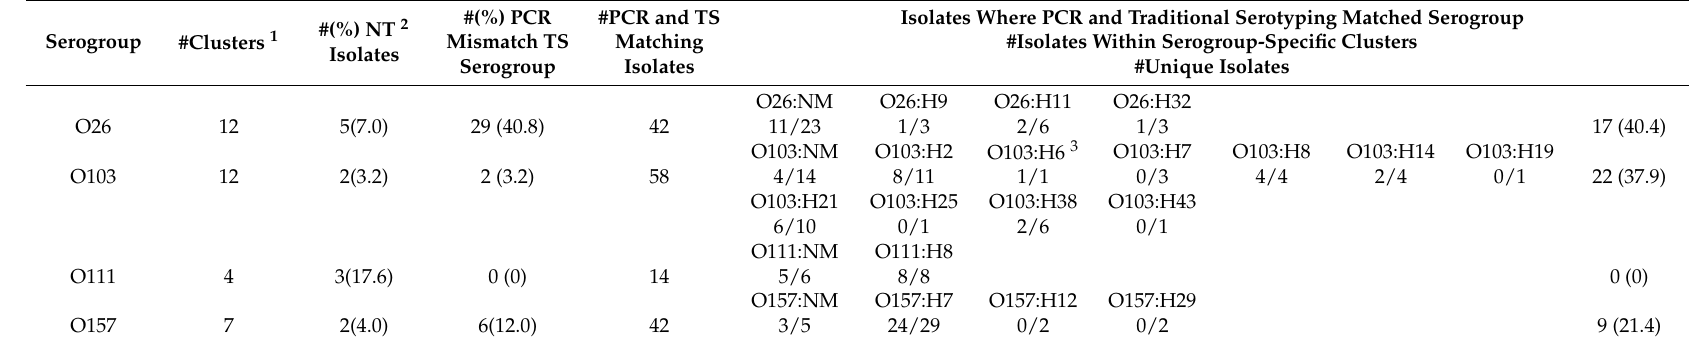
Table 3. Correspondence between traditional serotyping (TS) and pulsed field gel electrophoresis of isolates of O26 ( n = 71), O103 ( n = 62), O111 ( n = 17), and O157 ( n = 50) initially serogrouped by